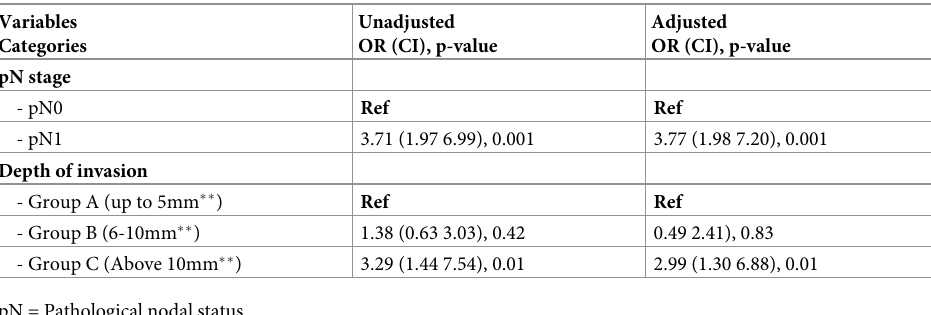
Table 4. Risk factors of recurrence.